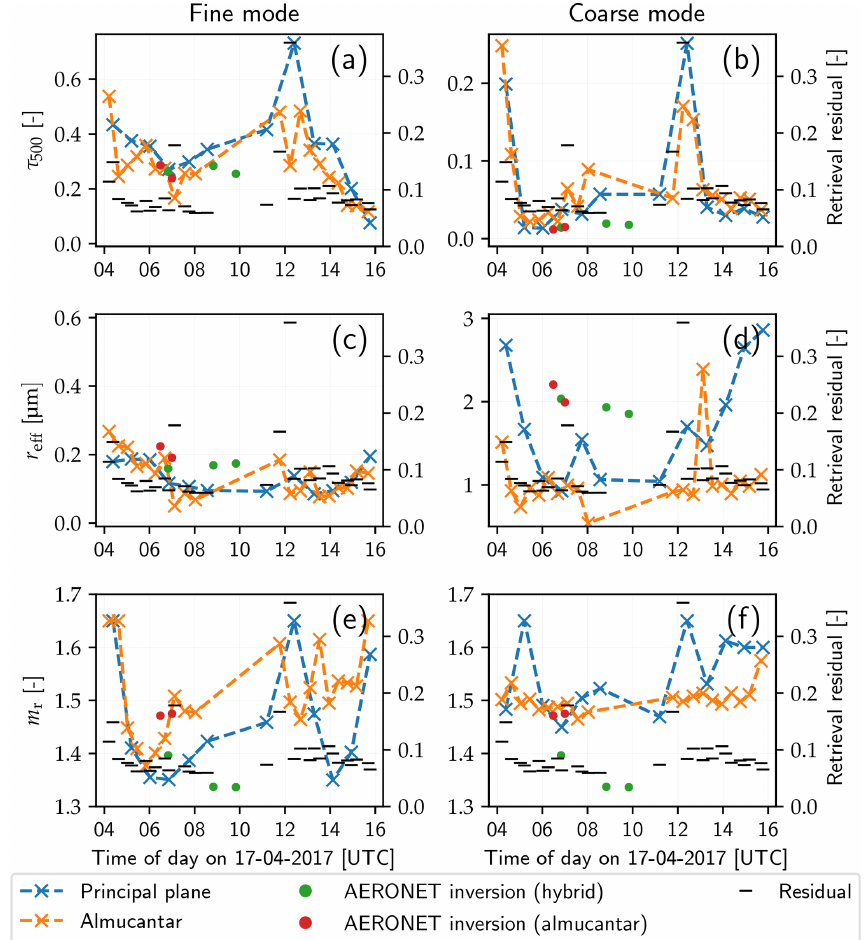
Figure 13. Fine- and coarse-mode trends of aerosol optical depth ( τ 500 ), mode effective radius ( r eff ), and real part of refractive index ( m r ) for 17 April 2017. Values obtained from principal plane scans are marked by blue crosses; those from almucantar scans are orange. The residual of the retrieval is shown by black markers. AERONET version 3 level 1.5 inversion results are shown as green and red dots, corresponding to retrieval of almucantar and hybrid scans, respectively. The refractive index is assumed to be equal for both modes in the AERONET retrieval.